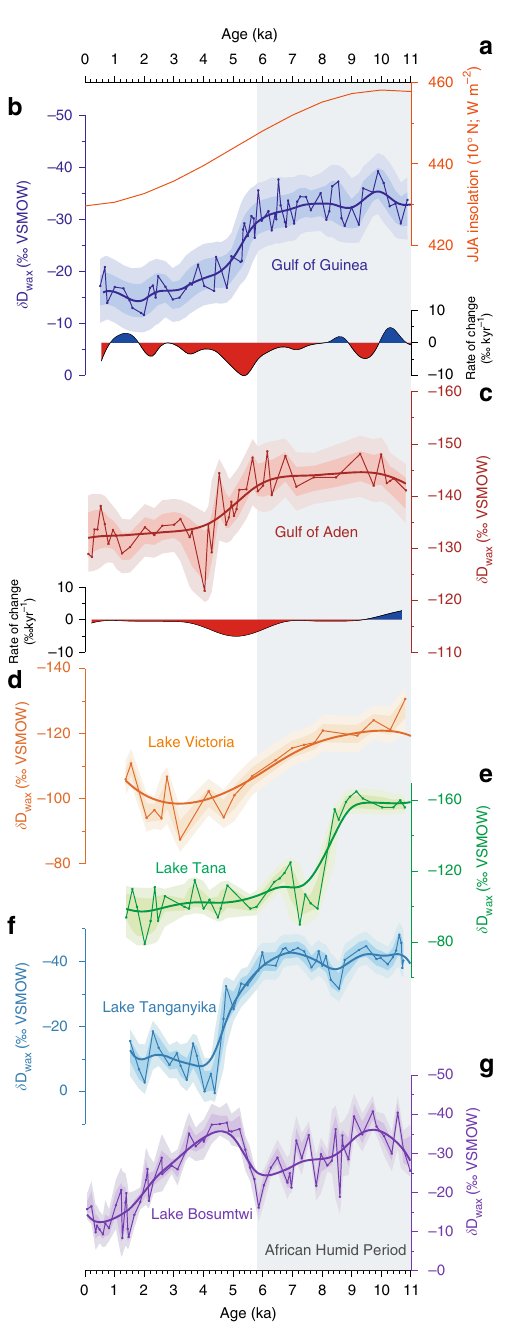
Fig. 5 Comparison with other African δ D wax records. a Mean JJA insolation at 10° N. b Gulf of Guinea δ D wax from core GeoB4905-4 (based on the C 29 n -alkane; ice-volume and vegetation adjusted; this study). c Gulf of Aden δ D wax (based on the C 30 fatty acid; ice-volume adjusted) from core P178- 15P 4 . d Lake Victoria δ D wax (based on the C 28 fatty acid; ice volume adjusted) 30 . e Lake Tana δ D wax (based on the C 28 fatty acid; ice volume adjusted) 31 . f Lake Tanganyika δ D wax (based on the C 28 fatty acid; ice volume and vegetation adjusted) 33 . g Lake Bosumtwi δ D wax (based on the C 31 n -alkane; ice volume and vegetation adjusted)[10]. Shadings indicate 68 and 95% uncertainty bounds, including analytical and age uncertainty. Thick lines represent Ruppert-Sheather-Wand smooth: rate of change ( ‰ kyr − 1 ) in b and c is based on this